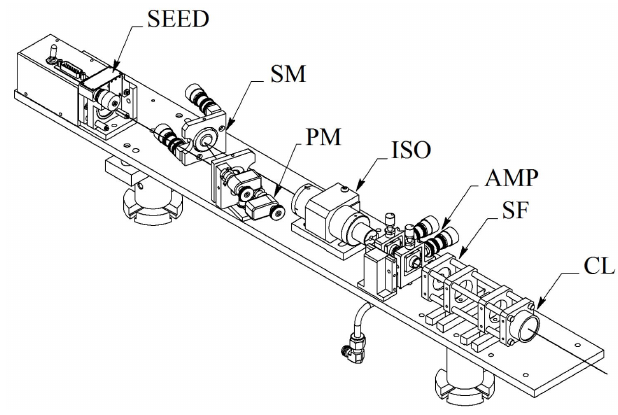
FIG. 6. The MOPA gain-switched diode seed laser and diode amplifier system: SM, steering mirror; PM, picomotor; ISO, optical isolator; AMP, single pass diode amplifier; SF, spatial filter; CL, cylindrical